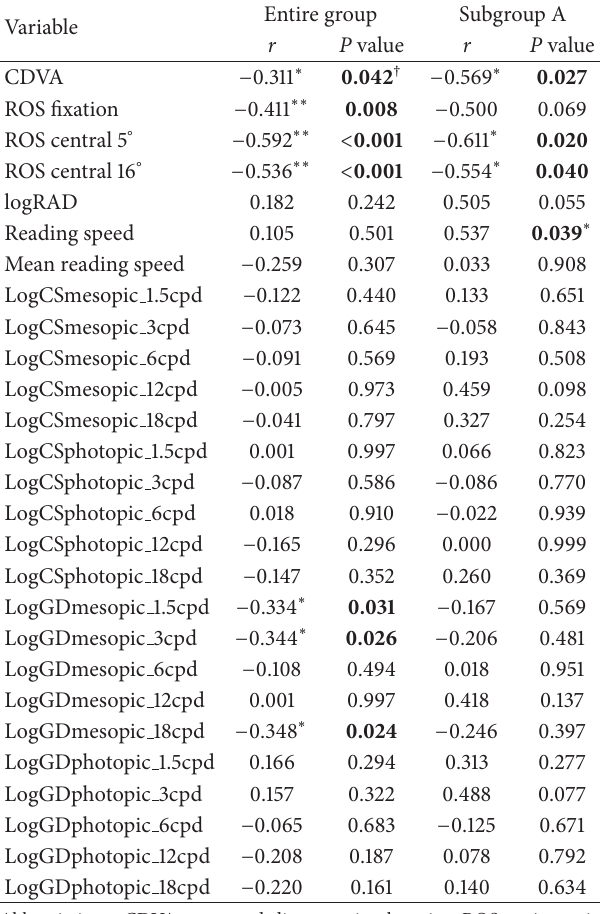
Table 2: Correlations between observed changes in mean foveal thickness and observed changes in other parameters for the entire study group and Subgroup